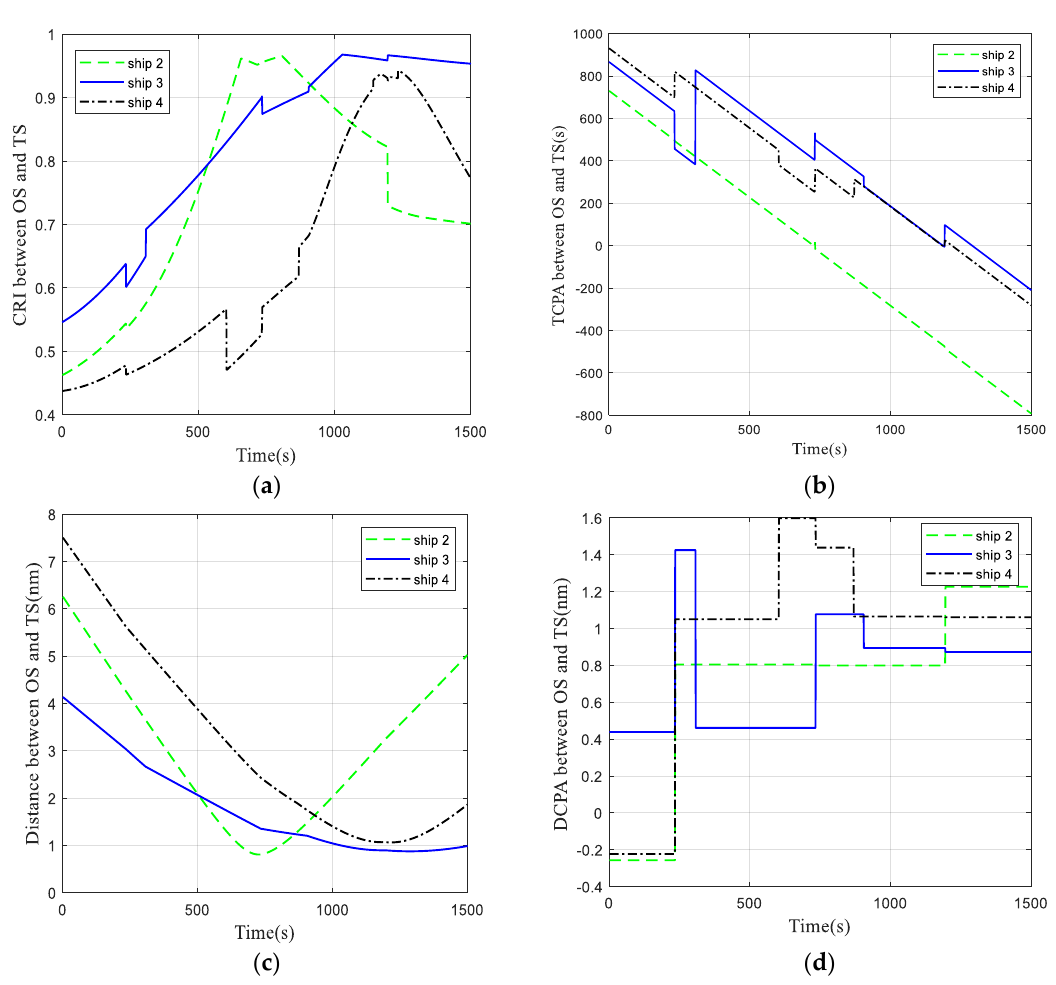
Figure 12. Real-time parameter changes under scenario 4: ( a ) the collision risk index ( CRI ) with the Target Ships (TSs), ( b ) the time to the closest point of approach ( TCPA ) with the TSs, ( c ) the relative distance with the TSs and ( d ) the distance to the closest point of approach ( DCPA ) with the TSs. Table 5. Actions taken by each ship in scenario 4.